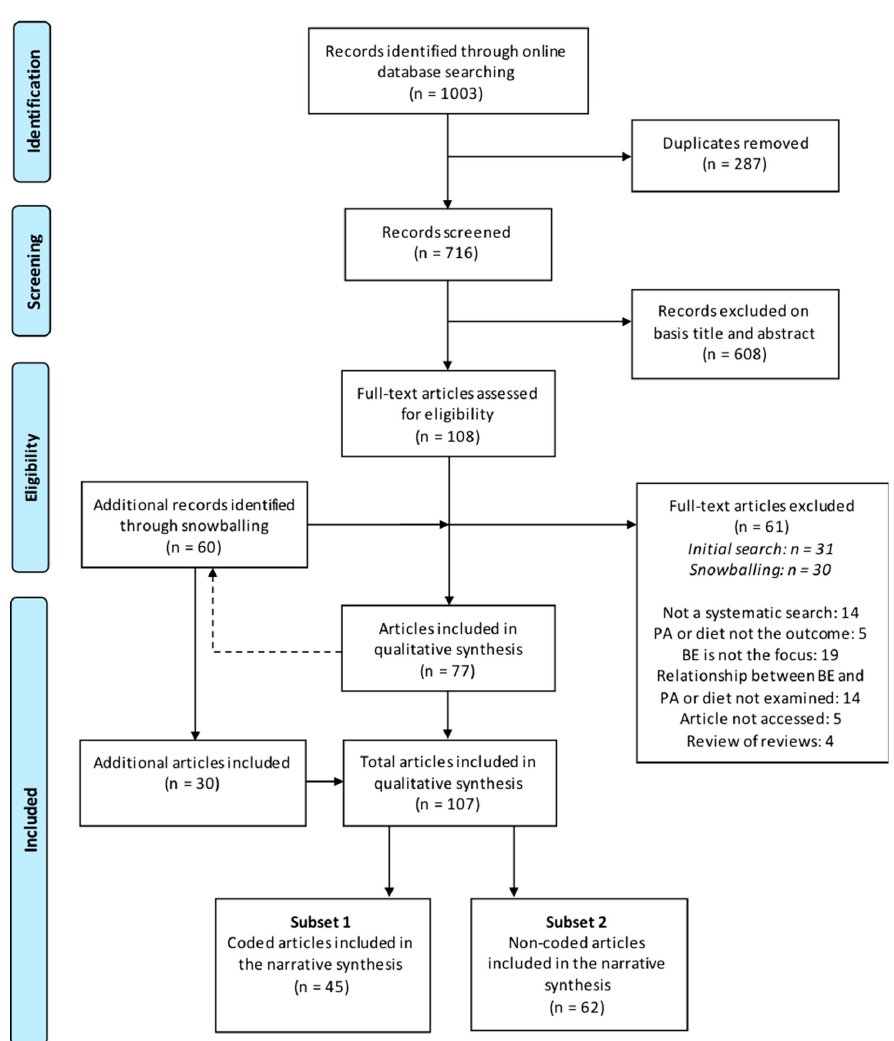
Figure 2. PRISMA flowchart of identification and selection of review papers for inclusion in the scoping review. Note: Figure adapted from Liberati et al., 2009 [59].